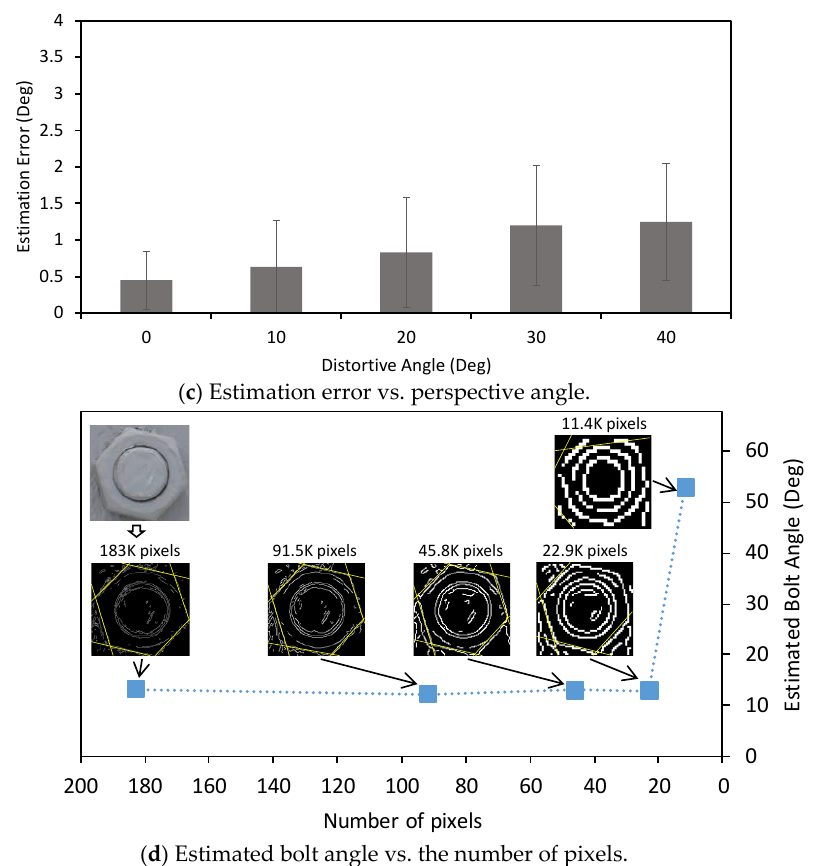
Figure 11. Accuracy of the proposed framework under different perspectives.